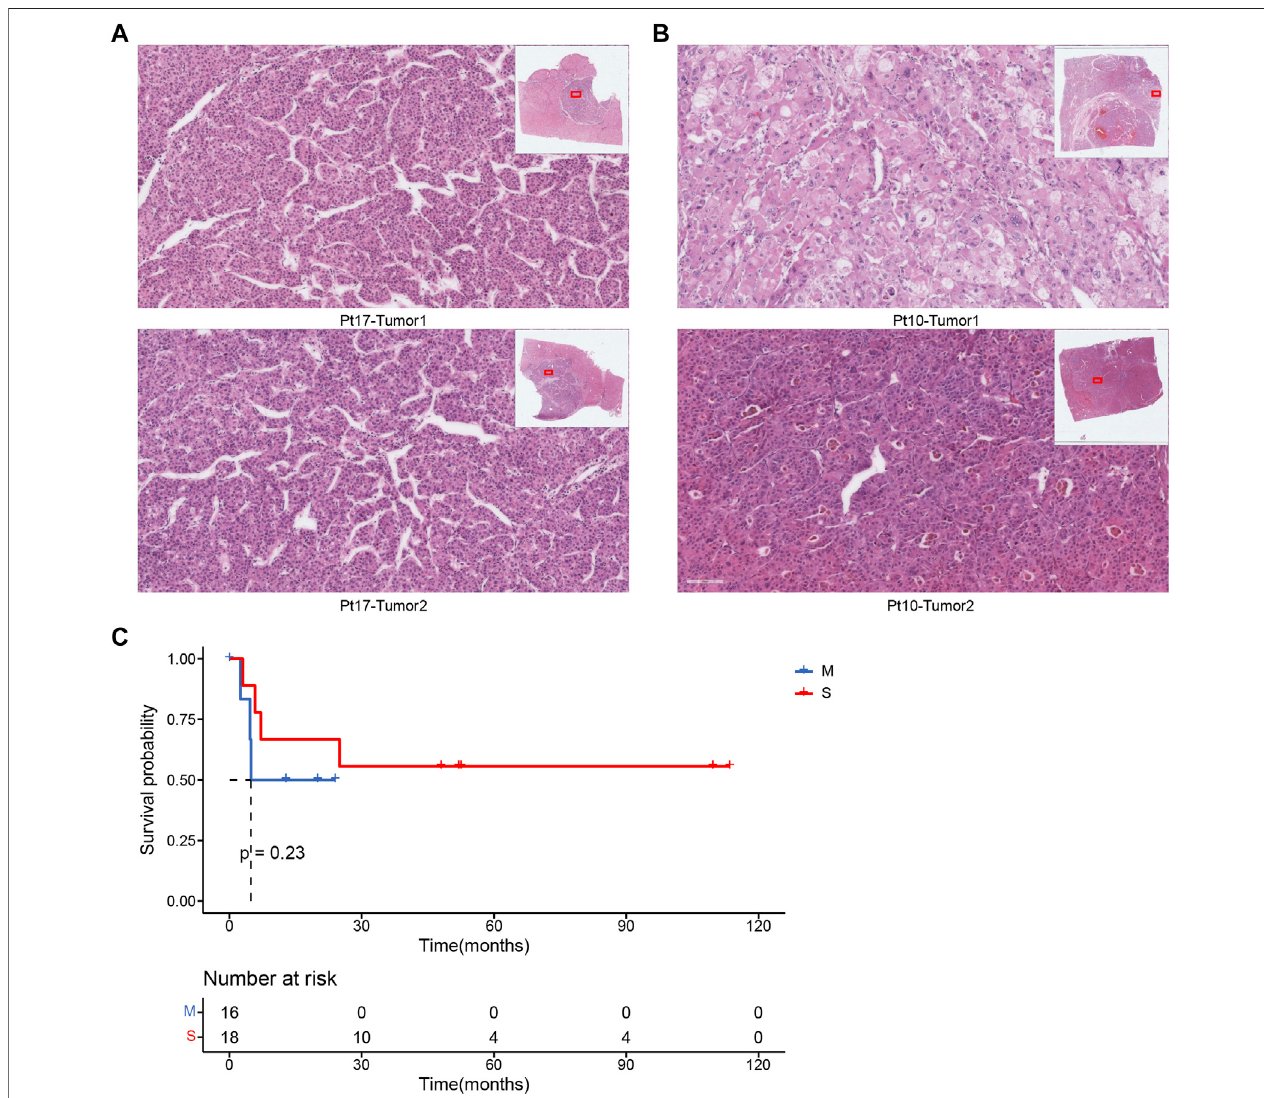
FIGURE 4 | (A) Pathological section of patient Pt17. (B) Pathological section of patient Pt10. (C) Associations between cancer types by pathologists and OS.